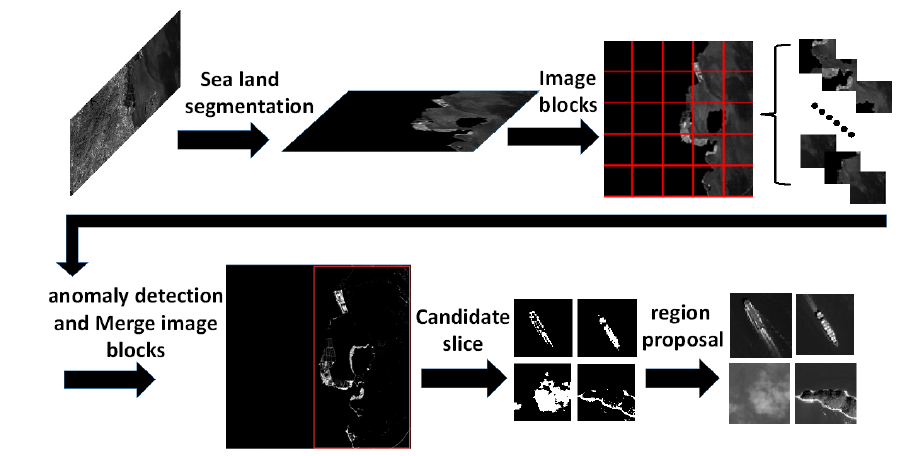
Figure 3. Extraction of candidate regions of ship targets based on anomaly detection algorithm.